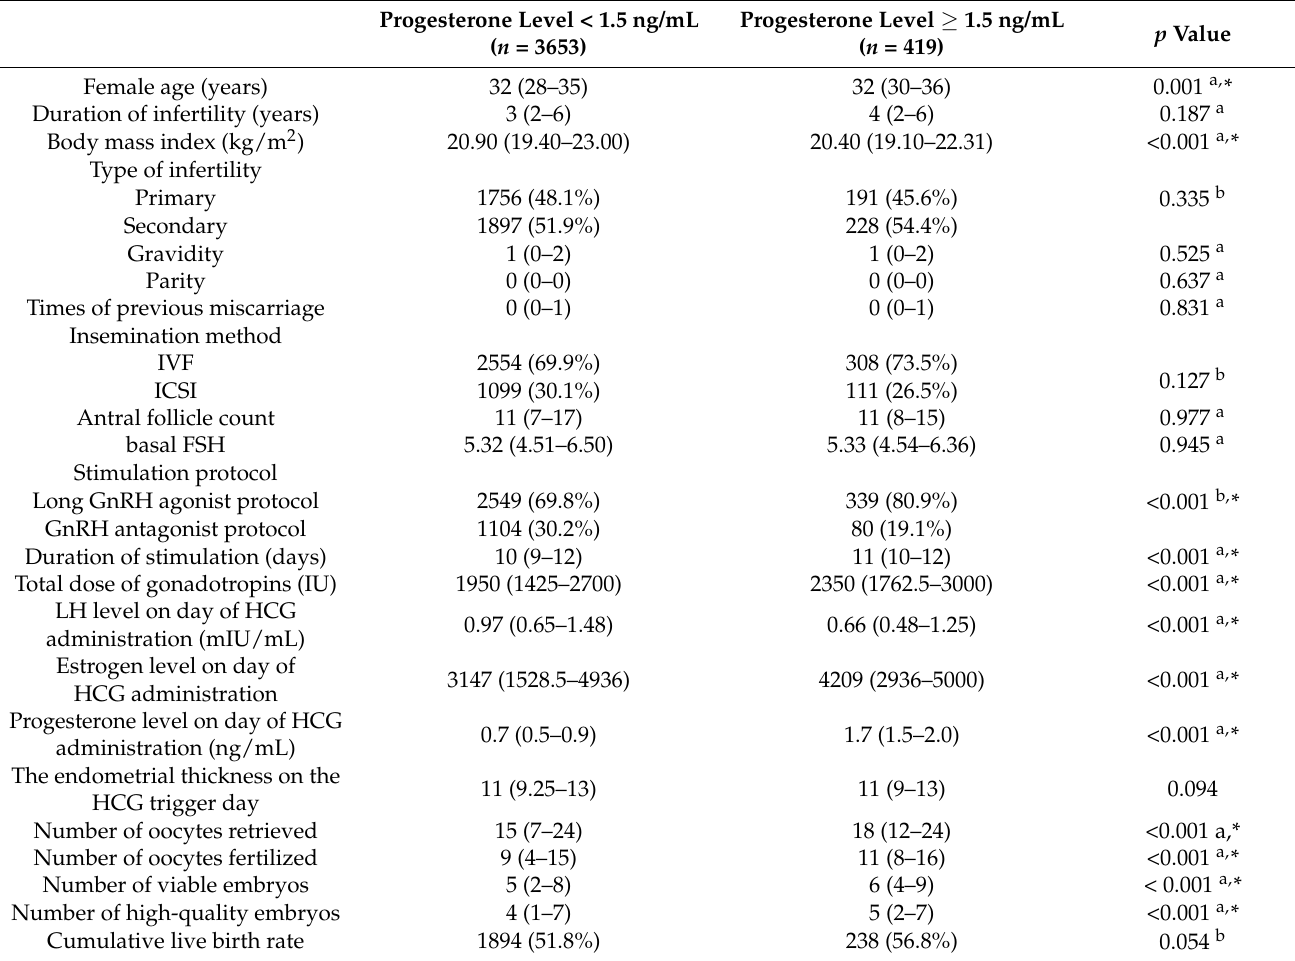
Table 1. Patient characteristics and cumulative live birth rate in groups with progesterone level <1.5 ng/mL and ≥ 1.5 ng/mL at trigger